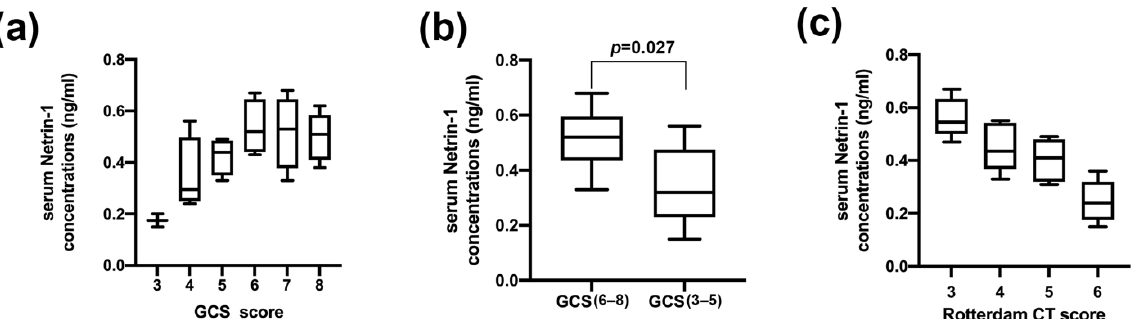
Figure 1. The relationship between serum Netrin-1 concentrations and trauma severity. ( a ) Com- parisons of serum Netrin-1 concentrations in patients with different Glasgow Coma Scale scores. ( b ) Differences in terms of serum Netrin-1 concentrations between critical TBI group (GCS 3–5 points) and severe TBI group (GCS 6–8 points). ( c ) Comparisons of serum Netrin-1 concentrations across Rotterdam computed tomography classification.